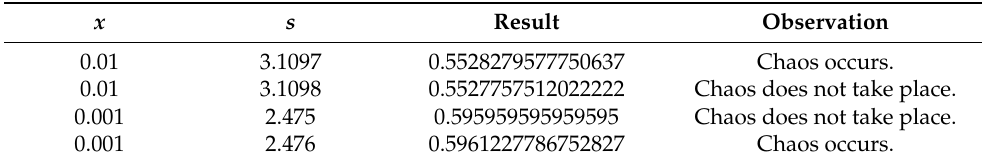
Table 1. Examples when chaos is done or not after 1000